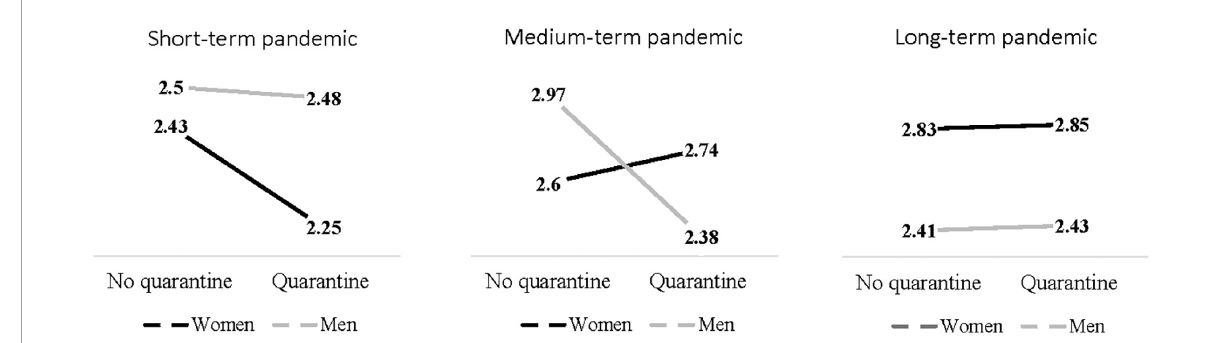
FIGURE2 Interactions between gender, individual quarantine and pandemic duration regarding